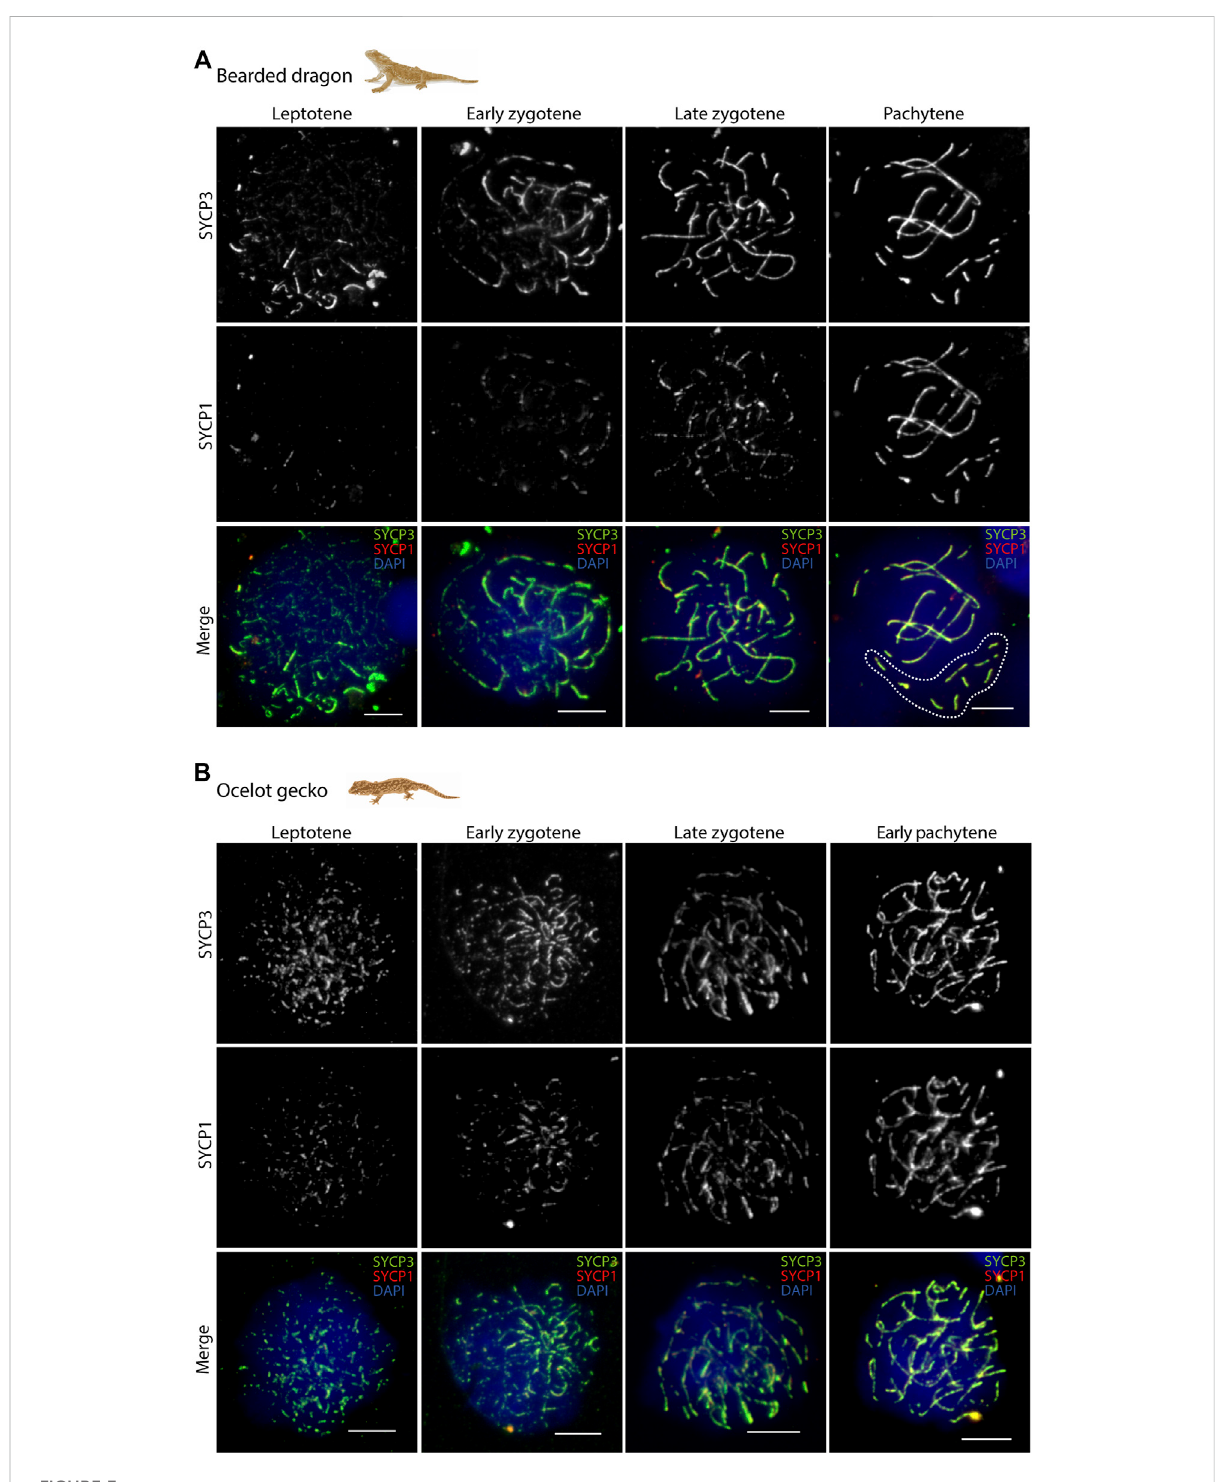
FIGURE 3 Synapsis dynamics during prophase I. Spermatocyte spreads labelled with antibodies against SYCP3 (green) and SYCP1 (red), counterstaining theDNAwithDAPI(blue)for (A) thebeardeddragonand (B) theocelotgecko.Scalebar:10 μ m.Whitedashedcircle:clusterofmicro-chromosomes.